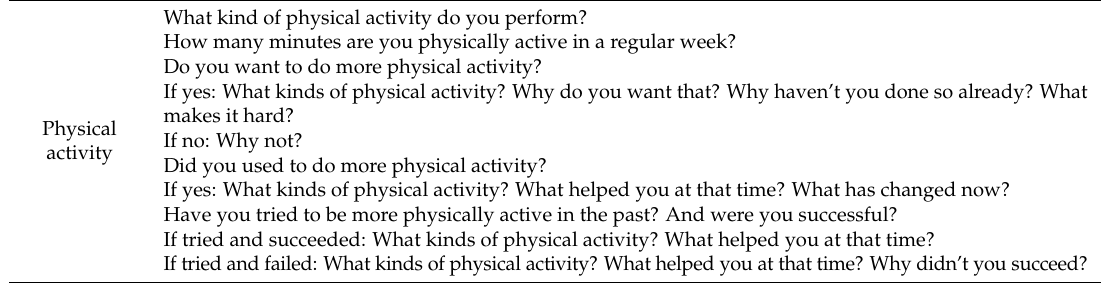
Table 1. Interview